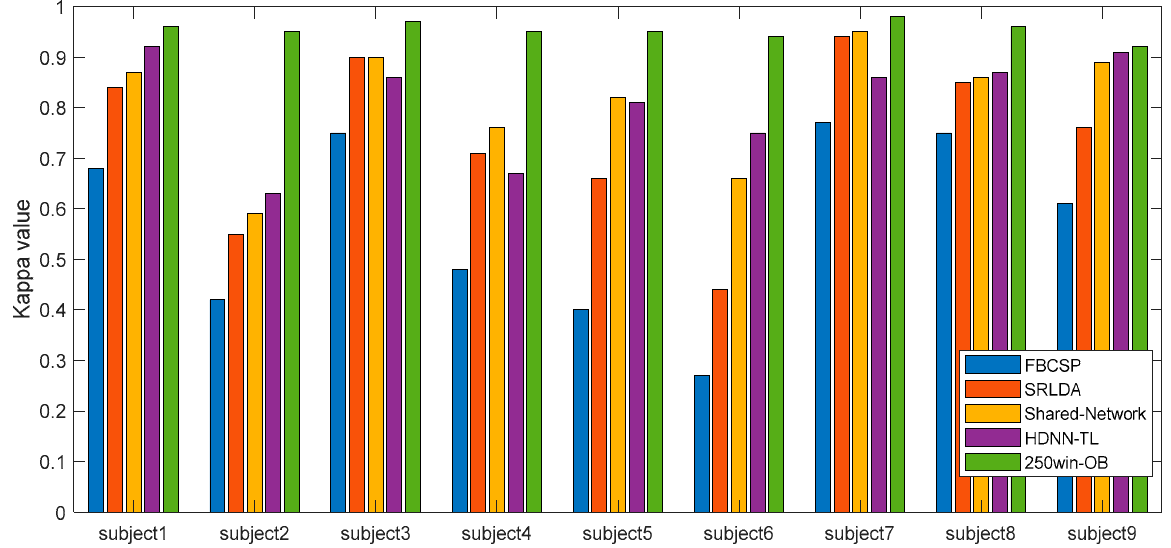
Figure 7. Performance comparison between existing methods and the proposed method.